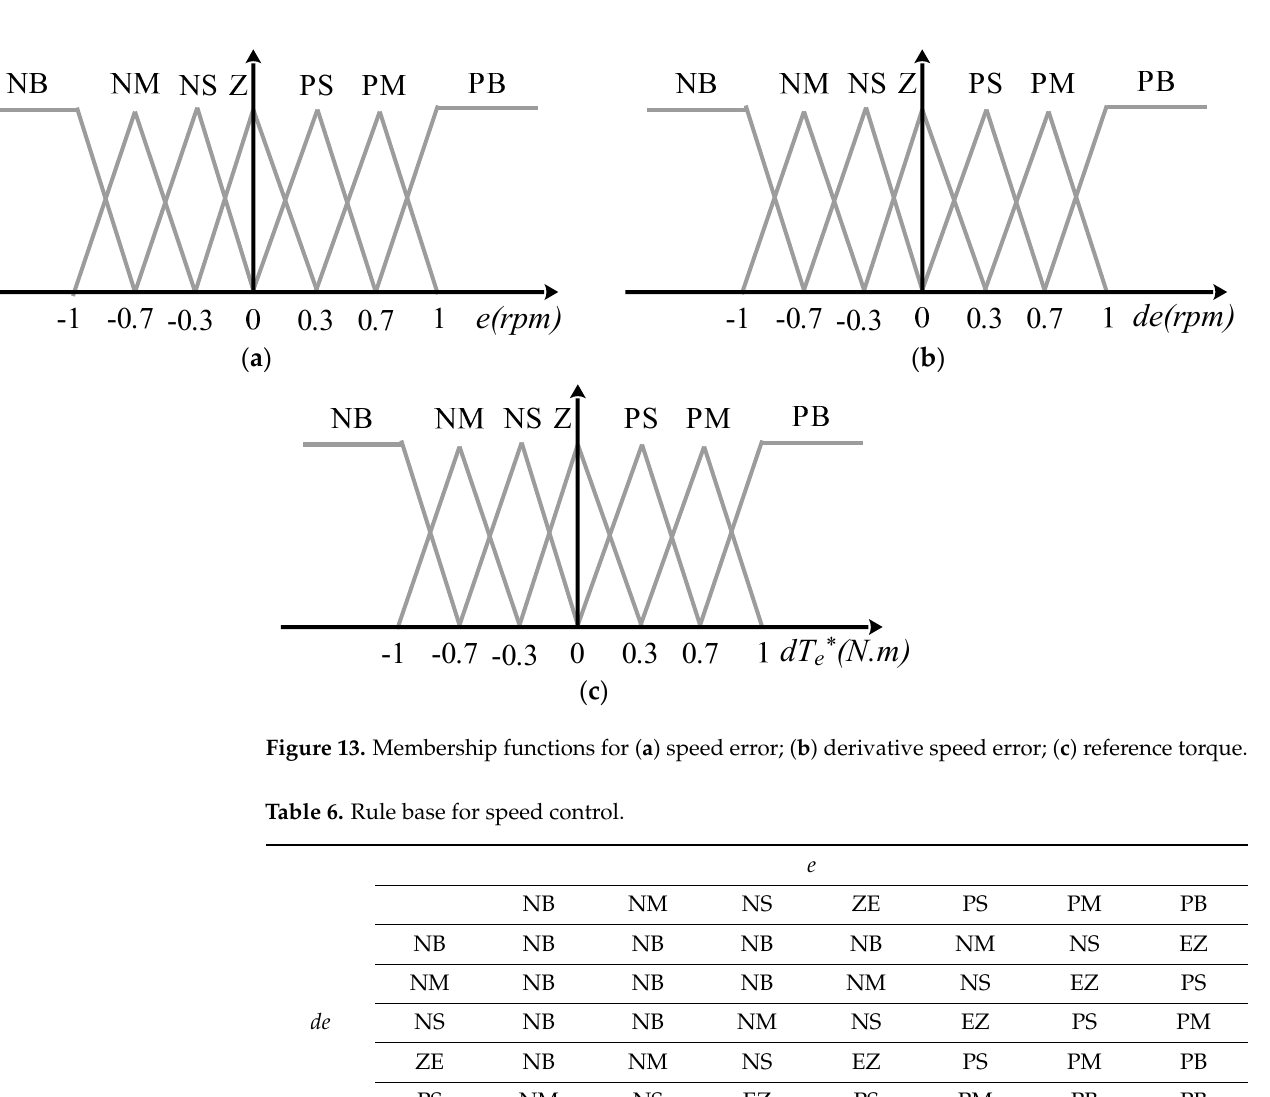
Table 6. Rule base for speed control.